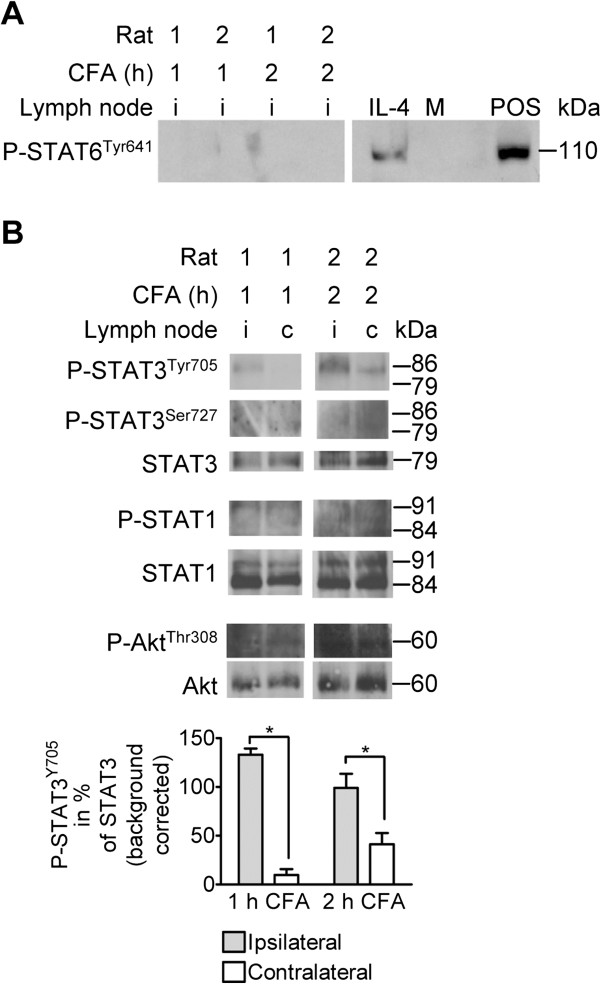
Phosphorylation of JAK downstream targets in cells from lymph nodes draining inflamed and noninflamed paws. Popliteal lymph nodes (i, ipsilateral; c, contralateral) were dissected from two animals each at 1 and 2 h post i.pl. CFA injection: Cells were isolated and cell lysates were analyzed using Western Blotting. Densitometry results are given as mean % expression of loading control ± SEM in the bar graphs. A) Tyrosine 641-phosphorylation of STAT6 (110 kDa) in CFA- and IL-4-stimulated lymphocytes, two out of 6 nodes analyzed per time point are shown. A commercially available phospho-STAT6 positive control (POS, BioLabs) was run on the same gel. M = protein marker. B) Tyrosine 705 (79/86 kDa)- and Serine 727 (86 kDa)-phosphorylation of STAT3, non-phosphorylated STAT3 (79 kDa), phosphorylated STAT1 (84/91 kDa), non-phosphorylated STAT1 (84/91 kDa), Threonine 308-phosphorylated Akt (60 kDa), and non-phosphorylated Akt (60 kDa). Stainings were performed on 3 nodes per time point; the staining for Tyrosine-phosphorylated STAT3 was performed on 6 nodes per time point. Statistical comparison of the ipsi- and contralateral side was performed using the Wilcoxon Matched Pair test; *P < 0.05. Representative immunoblots are shown. The same blot was probed sequentially with different antibodies. Lanes shown were run on the same gel, noncontiguous lanes are separated by thin white lines. Ser, Serine; Thr, Threonine; Tyr, Tyrosine.